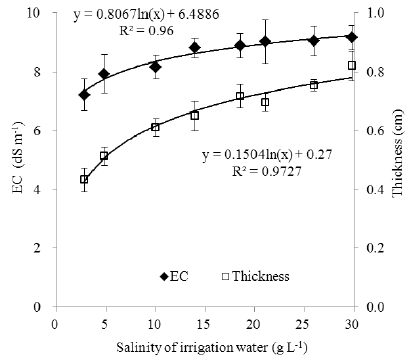
Figure 4. Variations in EC and thickness of soil salt crust drip irrigated with waters of different salinity levels in the Taklimakan Desert Highway Shelterbelt (corresponding sampling locations were shown in Figure 1). Error bars show 1 standard deviation.